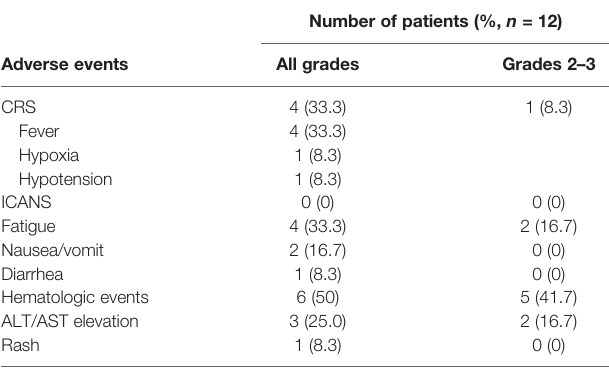
TABLE 2 | Adverse events of patients after anti-CD30 CAR-T cell infusion.